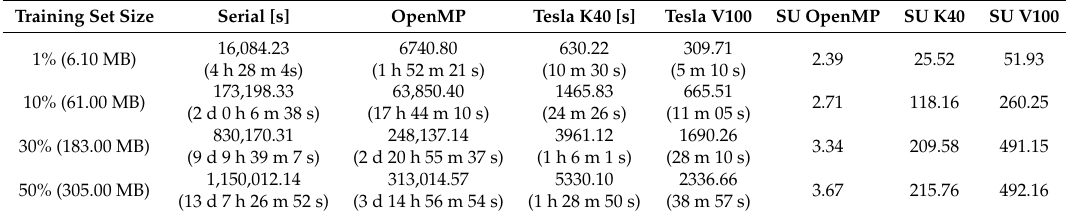
Table 2. Processing times for the PaviaC image. The speed-up is indicated with the abbreviation SU. Training Set Size Serial